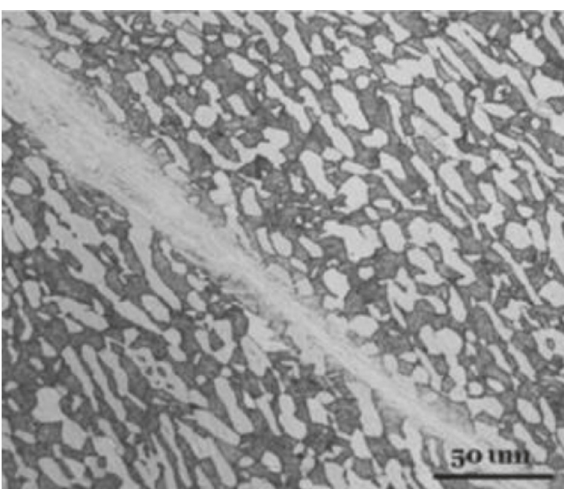
Figure 5: Optical micrograph of an adiabatic shear band in a bimodal microstructure of Ti6Al4V [16].